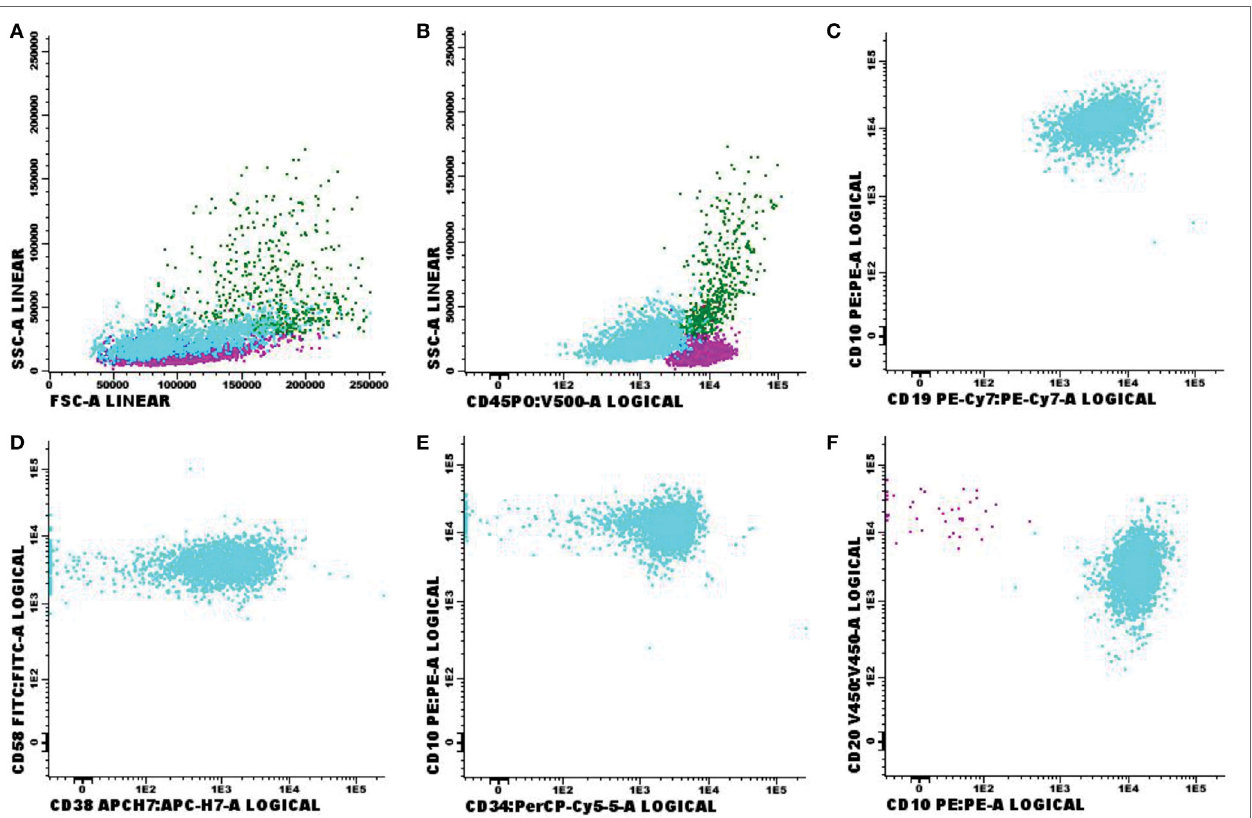
FigUre 3 | Flow cytometry results of suspected central nervous system infiltration by B-cell acute lymphoblastic leukemia. Presumptive diagnosis: suspected B-cell lymphoblastic leukemia. (a) Forward-scattered light (FSC size) and side-scattered light (complexity—SSC); (b) low-complexity blast population weakly expressing CD45 (light blue); (c) population of CD19 + and CD10 + B-lymphoid blasts; (D) strong expression of CD58 and moderate expression of CD38 in blast population; (e) CD10 + and CD34 + expression; (F) strong expression of CD10 in blast population. Sample collected in Transfix ® /ethylenediaminetetracetic acid with an approximate volume of 5 ml and 3 leukocytes/mm 3 and 0 red blood cells/mm 3 . Samples with 20,904 events acquired in Canto II (Becton Dickinson) and analyzed using the Infinicyt software (Cytognos). The frequency of populations in the viable cell region and CD45 + was 14,210 events.